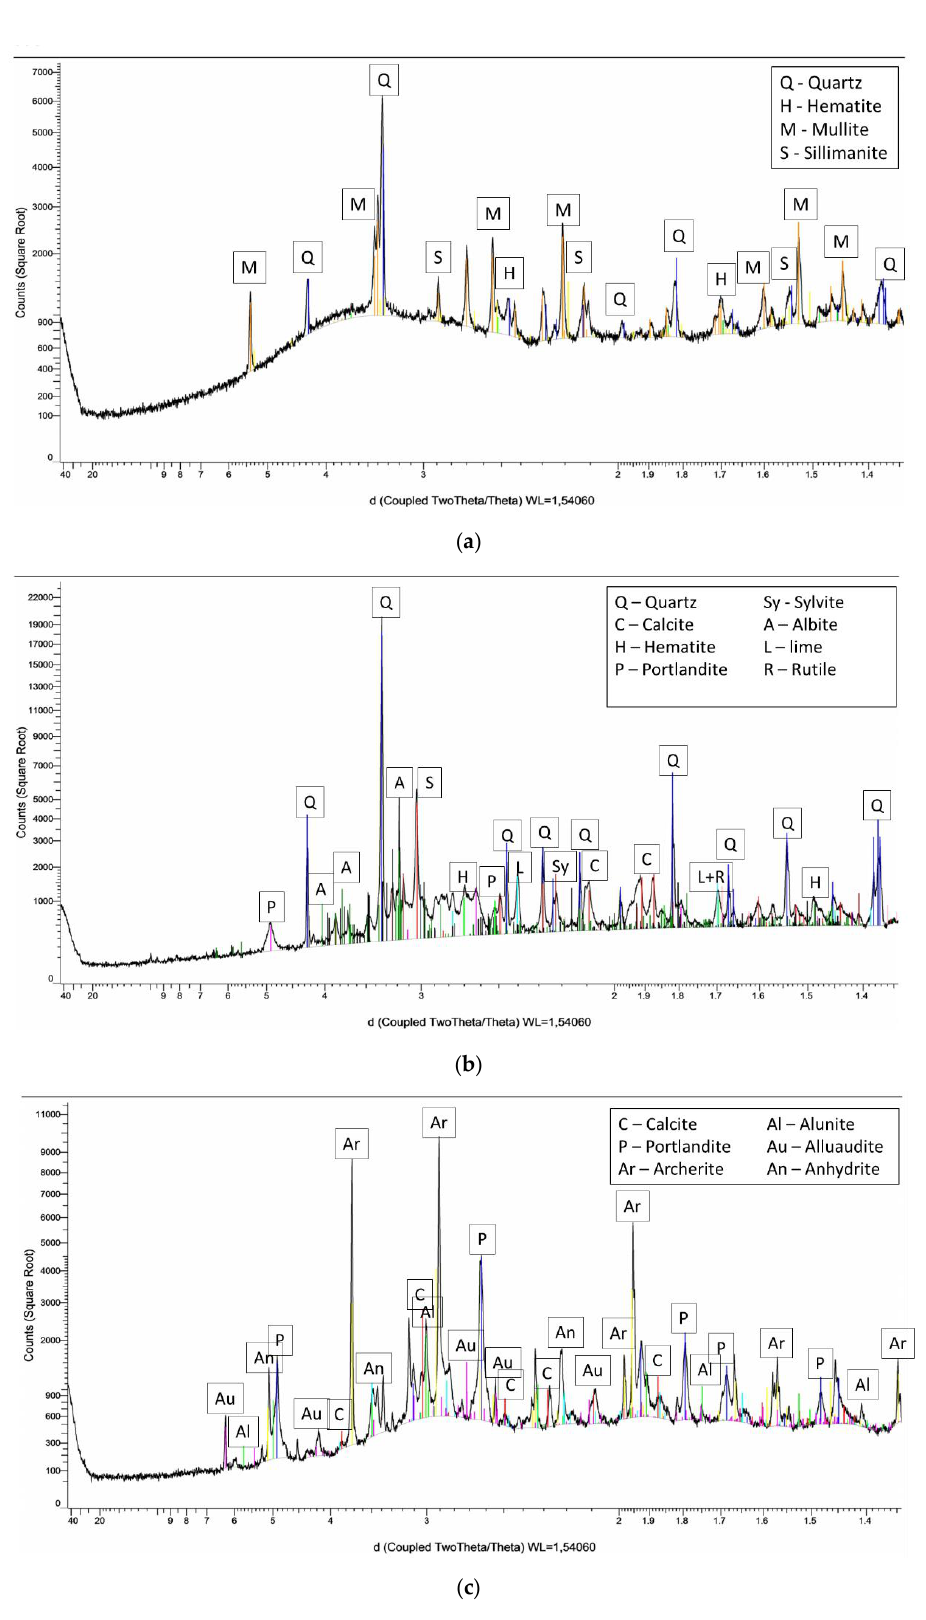
Figure 1. The X-ray di ff raction test (XRD) di ff ractograms: ( a ) silica fly ash from coal combustion (RFA), ( b ) co-combustion fly ash (CFA), ( c ) biomass fly ash